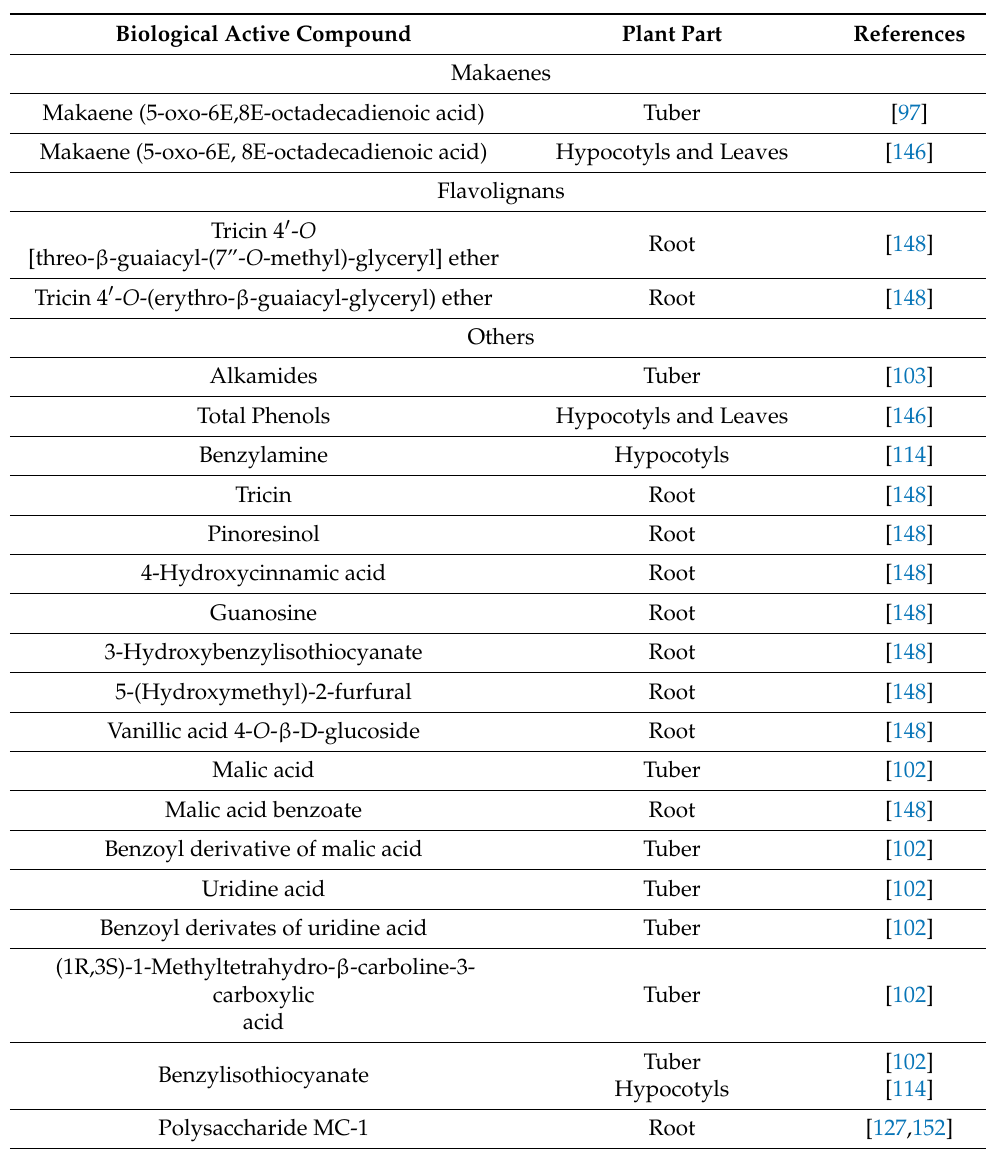
Table 2. Cont. Biological Active Compound Plant